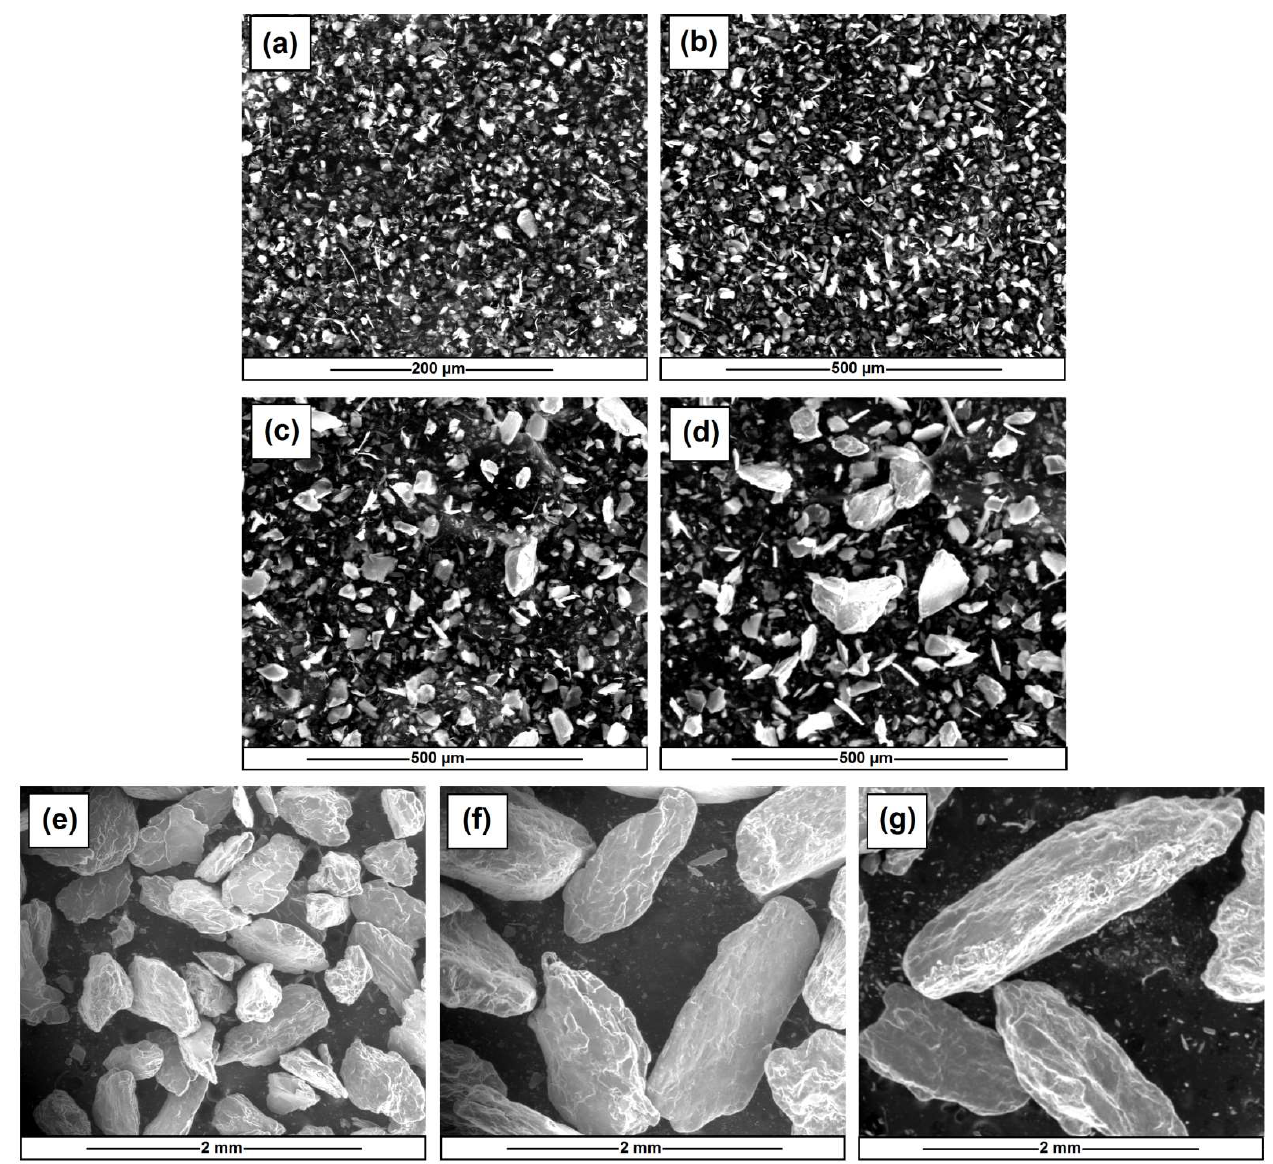
Figure 2. SEM images of talc: Mondana 8 HT ( a ), Mondana 15 HT ( b ), Mondana 35 HT ( c ), Mondana 50 HT ( d ), Mondana Scrub 250 ( e ), Mondana Scrub 500 ( f ) and Mondana Scrub 710 ( g ).